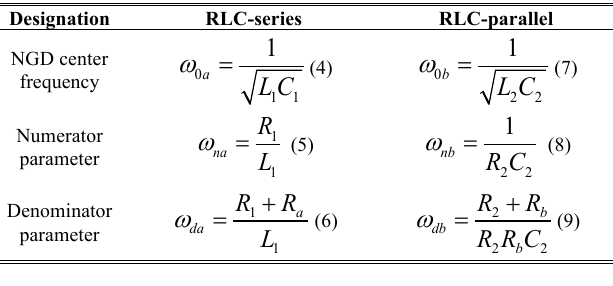
TABLE I. P ARAMETERS OF BP-NGD C ANONICAL F ORM OF RLC-S ERIES AND RLC- P ARALLEL T